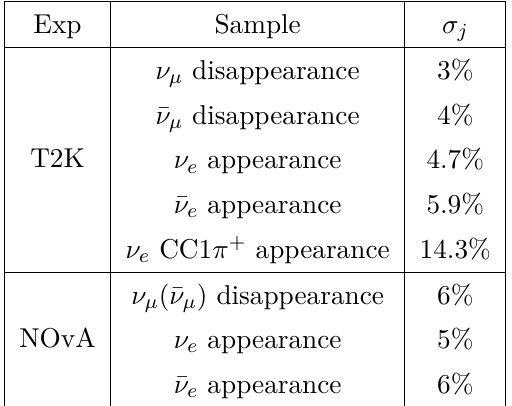
Table 3 . Summary table of systematic uncertainties. Normalization factors are applied to the following